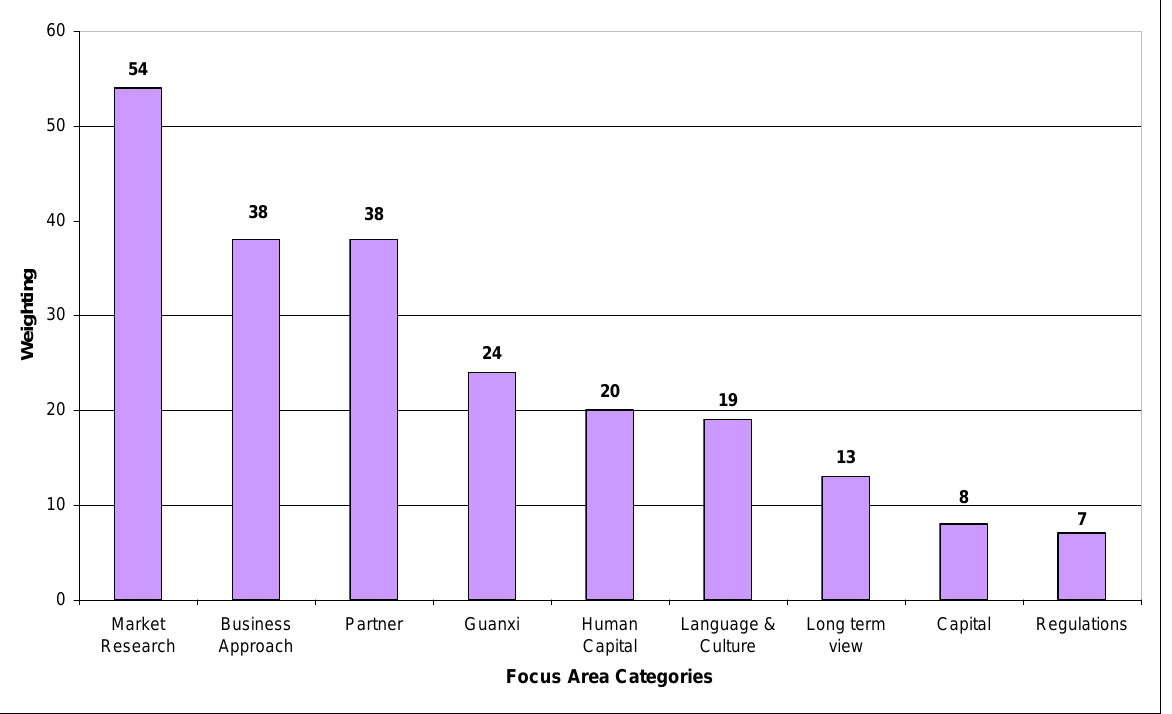
Figure 3: Categories of recommended focus areas and aggregate weightings. Three groupings within the clusters can be